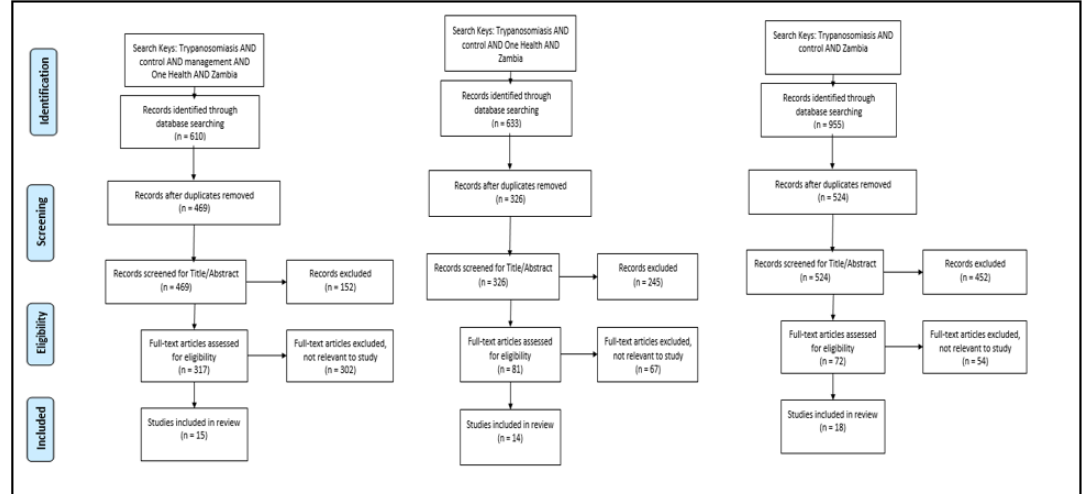
Figure A1. PRISMA diagrams showing three categories of searches conducted and selection criteria of literature included in the review.